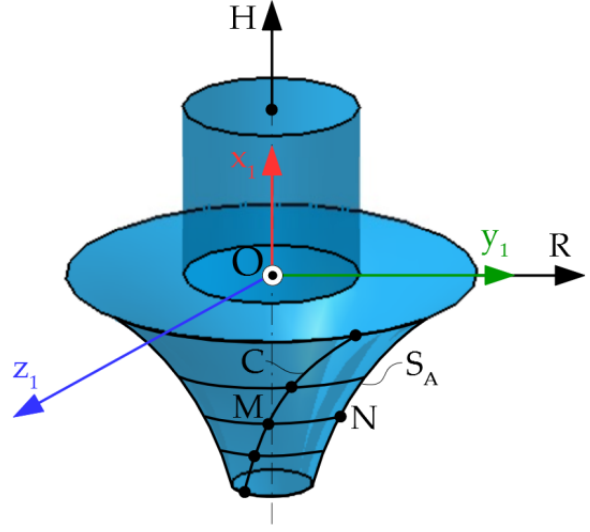
Figure 24. Axial section.